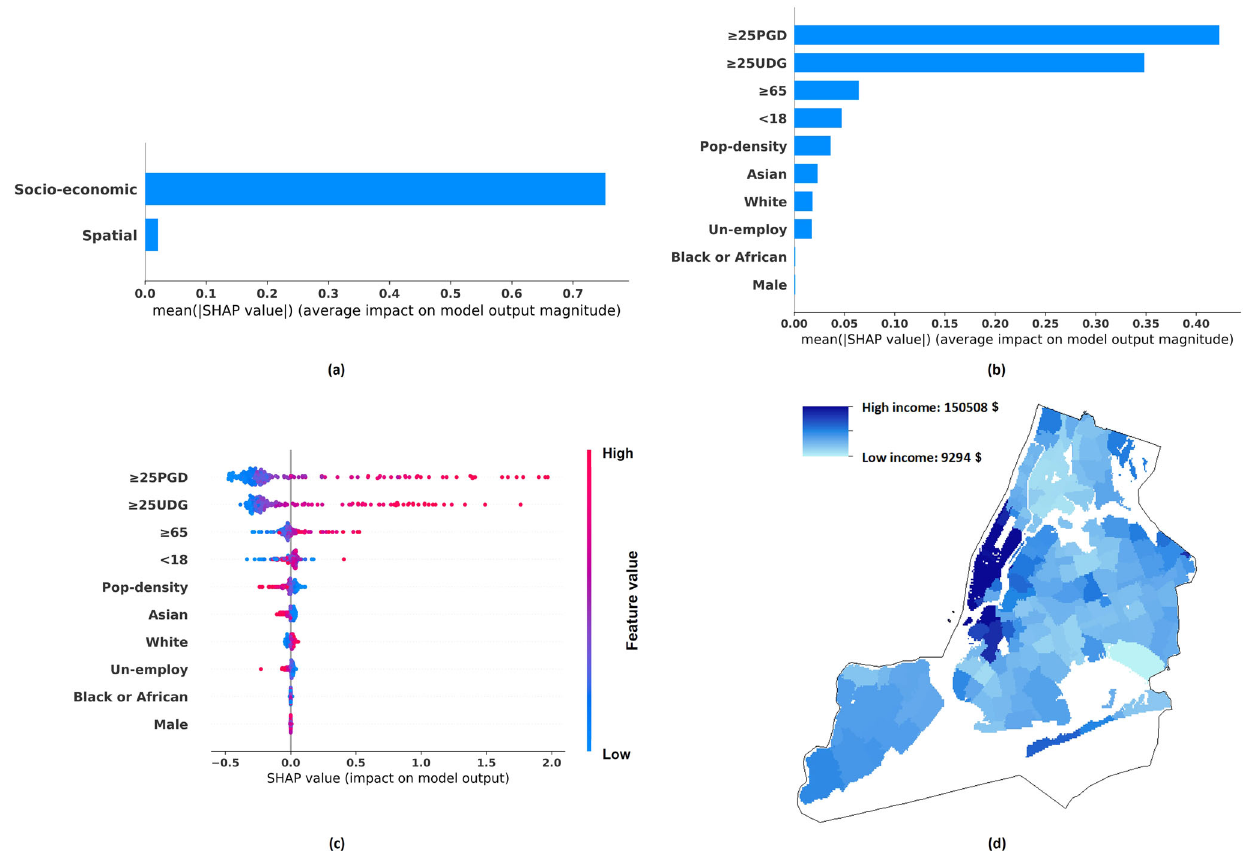
Fig. 4 ZIP-level per-capita income distribution and SHAP analysis results. a The mean absolute SHAP value indicating the total contribution of spatial or socio-economic features to ZIP-level per-capita income estimation. b The mean absolute SHAP value indicating the contribution of individual socio- economic features to ZIP-level per-capita income estimation. c The SHAP value indicating the contribution of individual socio-economic features to ZIP- level per-capita income estimation, with each dot corresponding to a value of a particular ZIP region. d ZIP-level per-capita income